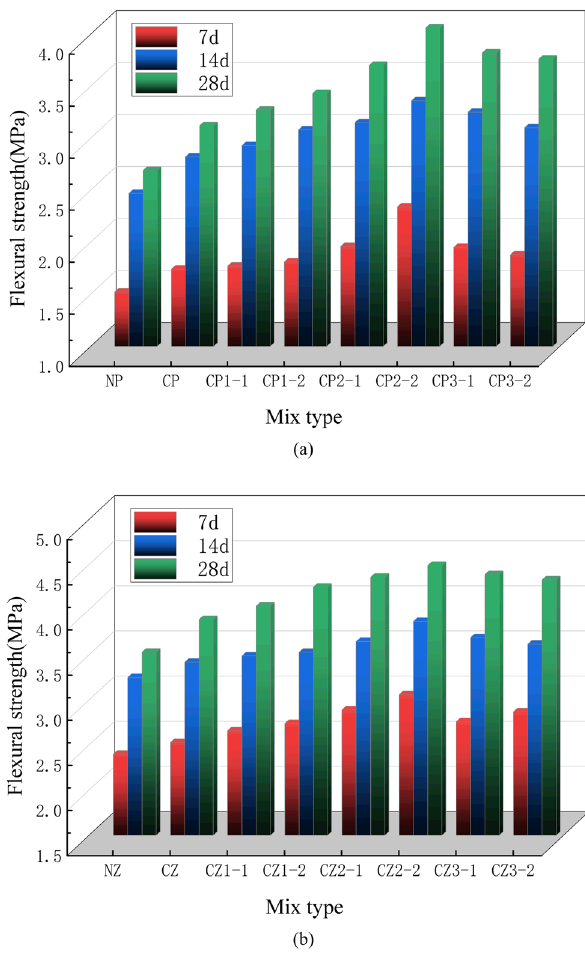
Figure 7: Flexural strengths of the RAC at various ages. ( a ) Ordinary mixing mode and ( b ) vibration mixing